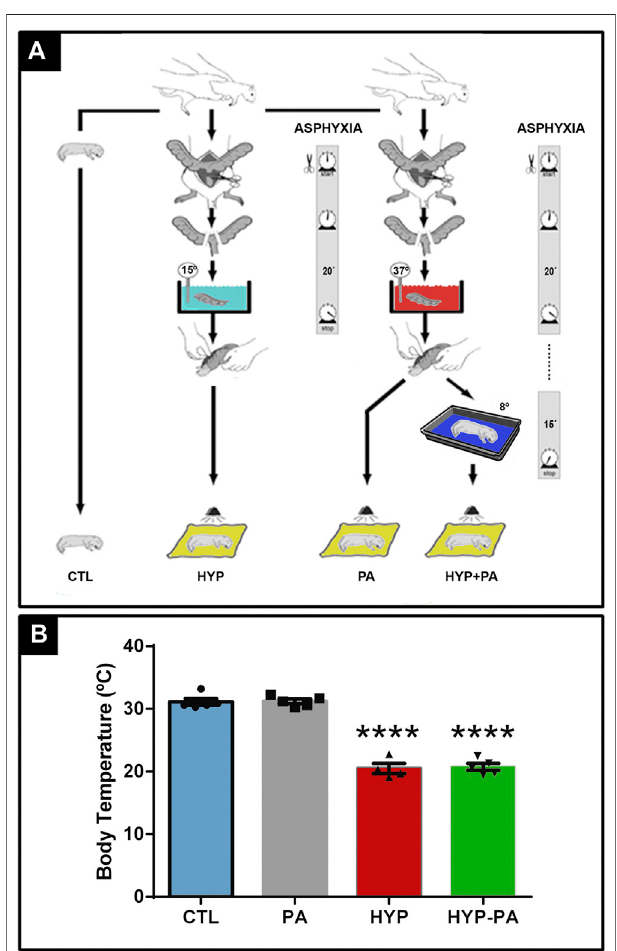
FIGURE1| Experimental model designandhypothermictreatment. (A) : Severe perinatal asphyxia was induced by a hypoxia-ischemia non-invasive model. Term pregnant rats were sacri fi ced and immediately hysterectomized after the fi rst pup was delivered vaginally. These normally delivered pups were used as controls (CTL). The remaining full-term fetuses, still inside the uterine horns, were transiently immersed in a water bath for 20 min at 37 ° C (PA) or at 15 ° C (HYP) for asphyxia induction. After asphyxia, the uterine horns were opened, pups were removed, and placed for recovery under a heating lamp for 1 h. Alternatively, after PA treatment fetuses were removed from the uterine horns and immediately exposed to8 ° C for 15 min (HYP-PA). (B) : Core temperature of pups was measured using a digital thermometer probe. Signi fi cant decrease of core temperature in HYP and HYP-PA related to CTL and PA normothermic groups con fi rmed the ef fi cacy of both cold treatments. Two way ANOVA, signi fi cant interaction F (cid:2) 164.2, p < 0.0001, Tukey´s multiple comparison test, p < 0.0001 (CTL vs. HYP and PA vs. HYP-PA). Asterisks indicate signi fi cant differences with CTL. ****: p < 0.0001.